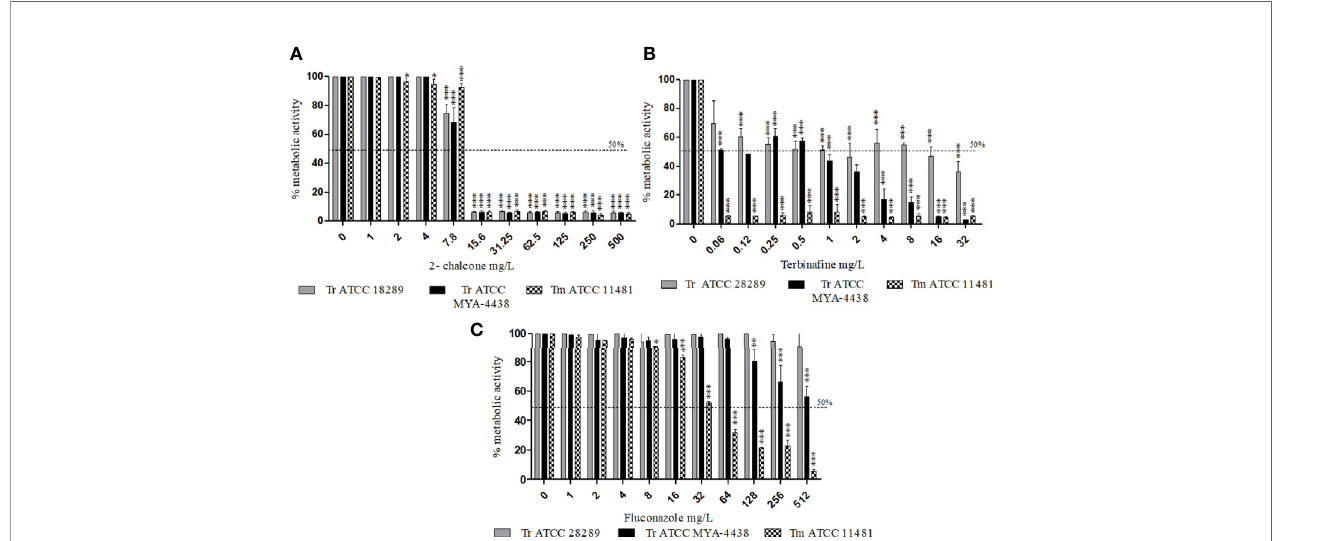
FIGURE 3 | Effect of 2-chalcone (A) , terbina fi ne (B) , and fl uconazole (C) on planktonic cells of T. rubrum ATCC 28189, T. rubrum ATCC MYA-4438, and T. mentagrophytes ATCC 11481 measured using the XTT reduction assay. The compounds 2-chalcone and terbina fi ne were more potent against planktonic cells than fl uconazole. The compounds 2-chalcone, terbina fi ne, and fl uconazole inhibited the cellular metabolic activity in the planktonic form at the concentration used for bio fi lm formation (10 6 cells/mL) of all strains tested, from the concentration of 15.6, 0.06, and 512 mg/L respectively. (*p < 0.05; **p < 0.01; ***p < 0.001). Tr, T. rubrum , Tm- T. mentagrophytes